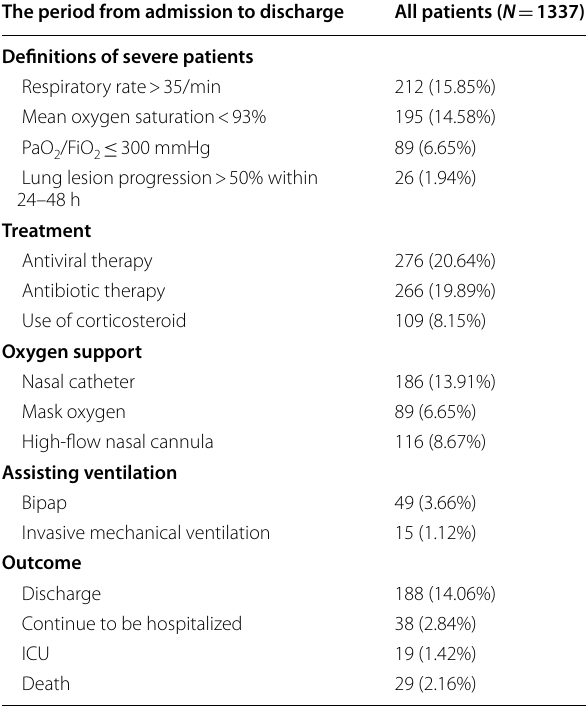
Table 3 Management of COVID‑19 patients in the clinic